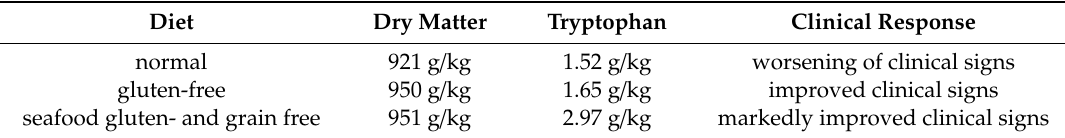
Table 1. Tryptophan content in three di ff erent commercially available food samples and owners’ subjective perception of clinical